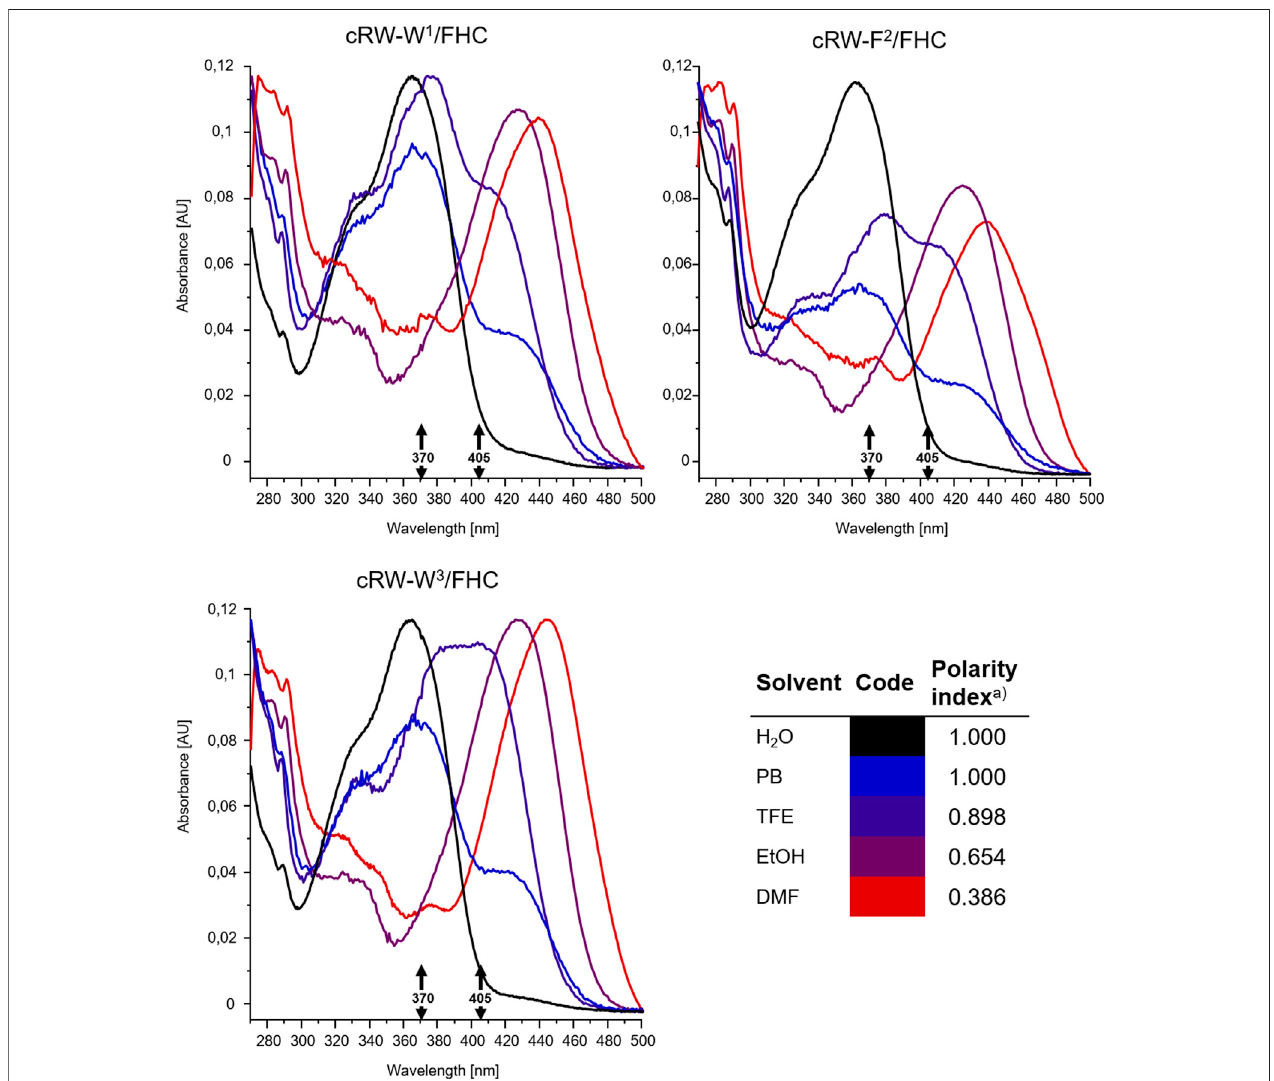
FIGURE 5 | Intensity-normalized absorbance spectra from 8 µM solutions of the FHC-labelled cWFW analogues in solvents of different polarities, colored according to the polarity index (Reichardt and Welton, 2019, insert, “ a) ” ). Black arrows mark excitation wavelengths used for fl uorescence measurements and microscopy (370 and 405